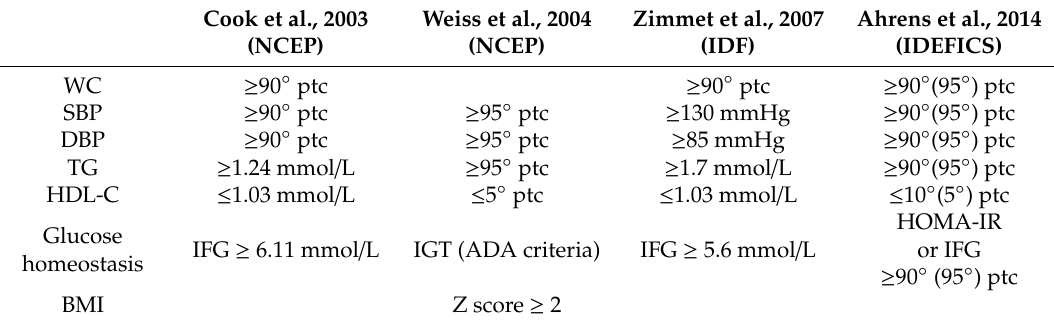
Table 1. Definition of metabolic syndrome in